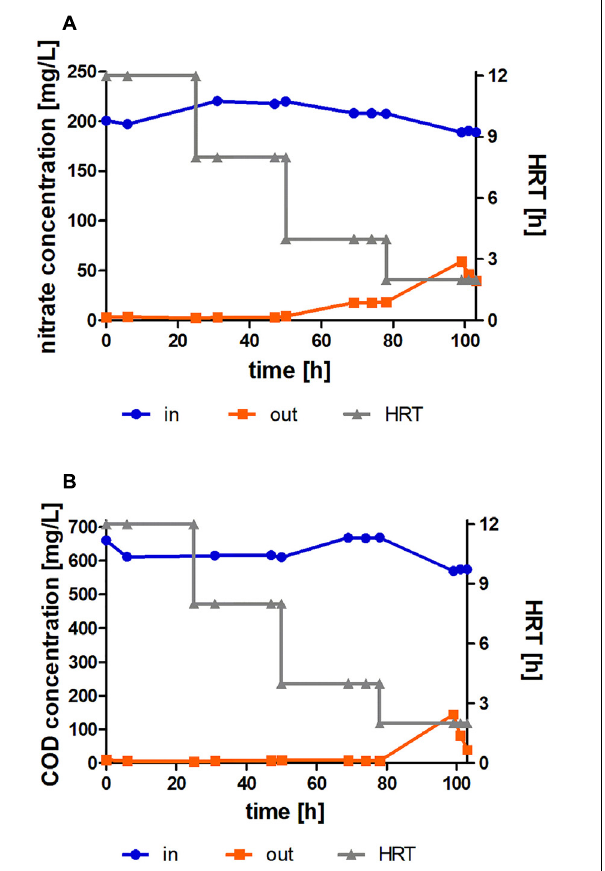
FIGURE 7 | (A) Nitrate concentration at the entrance and exit of the continuous moving bed bioreactor with time, where the initial concentration is 200 mg/l, at variable hydraulic retention times (HRTs) (2, 4, 8, and 12 h) in continuous experiment with biomass immobilized in aqueous solution at a C:N ratio of 3:1. (B) COD concentration at the entrance of the continuous bioreactor with time, where the initial concentration is ca. 700 mg/l, at variable HRTs (2, 4, 8, and 12 h) vs. COD concentration at the exit of the continuous bioreactor, when the initial concentration is ca. 700 mg/l at variable HRTs (2, 4, 8, and 12 h) in biomass immobilized in aqueous solution at a C:N ratio of 3:1. The data are means of three replicates + standard